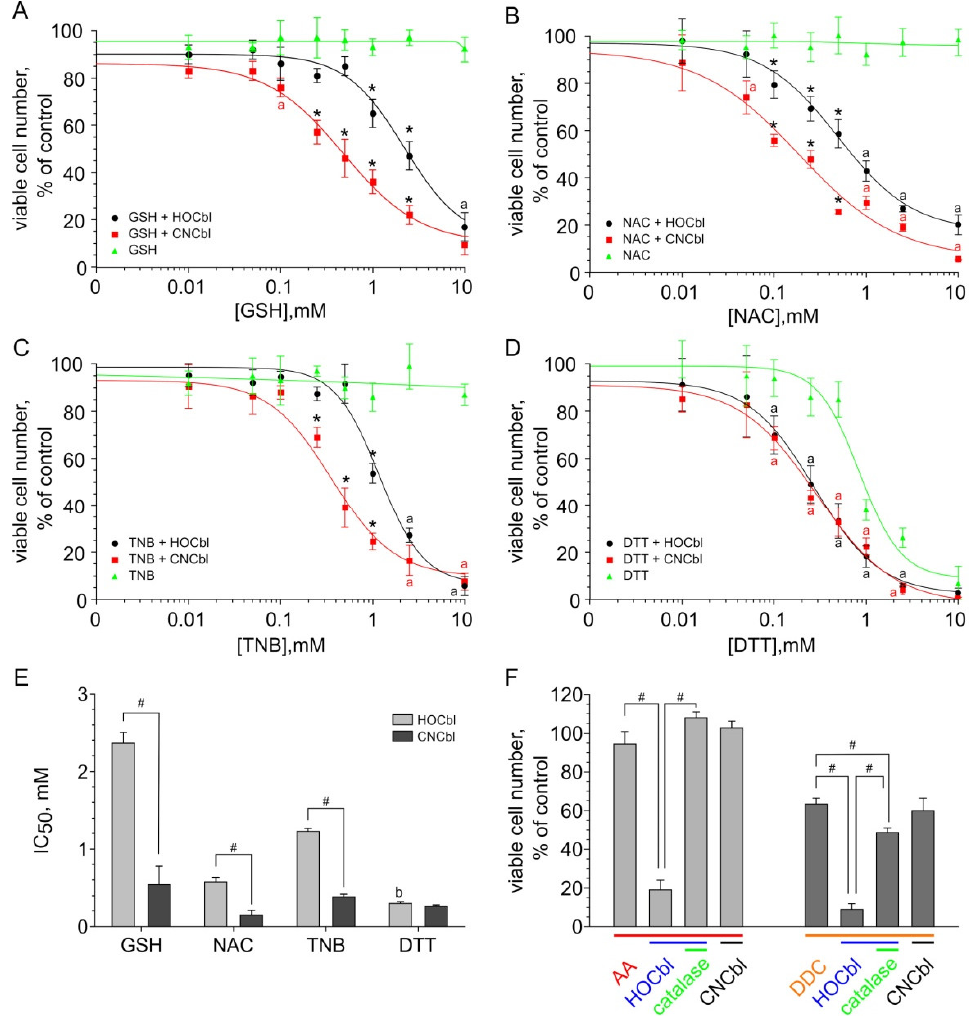
Figure 6. Cytotoxic effect of combinations of cobalamins with thiols ( A – D ), IC50 values for combinations of cobalamins with thiols ( E ), and cytotoxicity of combinations of cobalamins (25 μM) with AA (0.5 mM) and DDC (1 mM) ( F ). The results were expressed as the mean ± standard deviation. Data were analyzed using one-way ANOVA followed by Tukey's test. ( A – D ) * Differences are significant compared with other two groups; a significant differences between the cobalamin+thiol and thiol groups. ( E , F ) # significant differences between the groups; b differences are significant compared with combinations HOCbl + monothiols, p < 0.05.